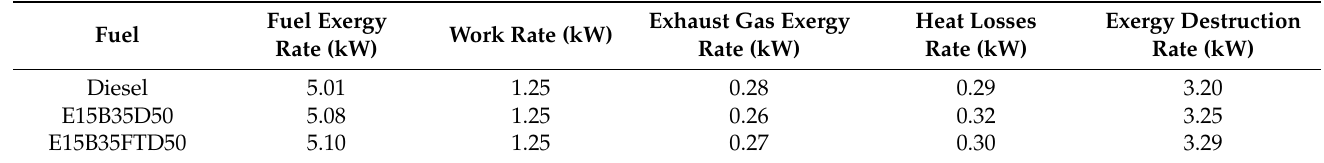
Table 5. Exergy distribution in the engine control